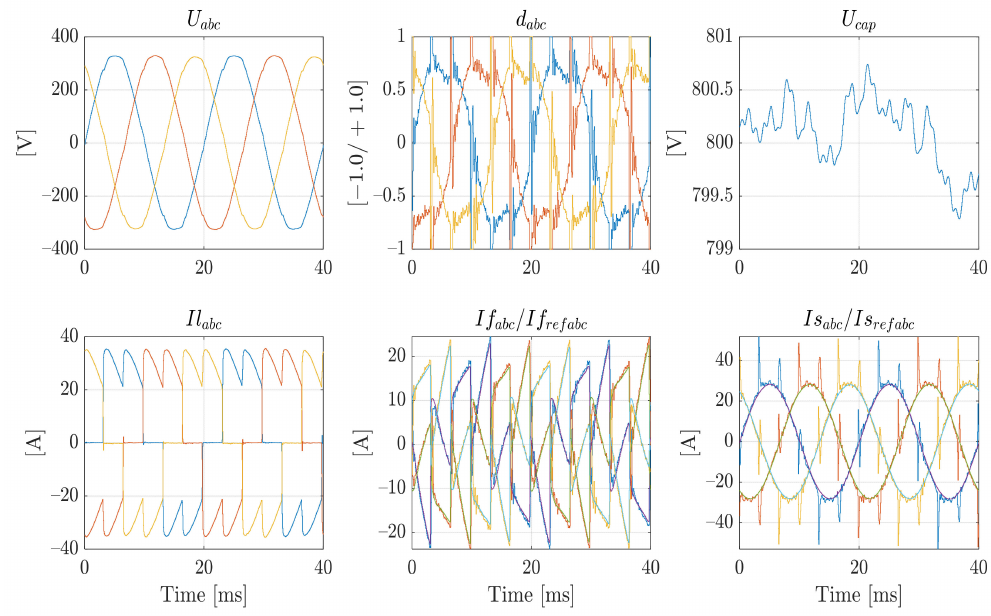
Figure 9. Results of the PI